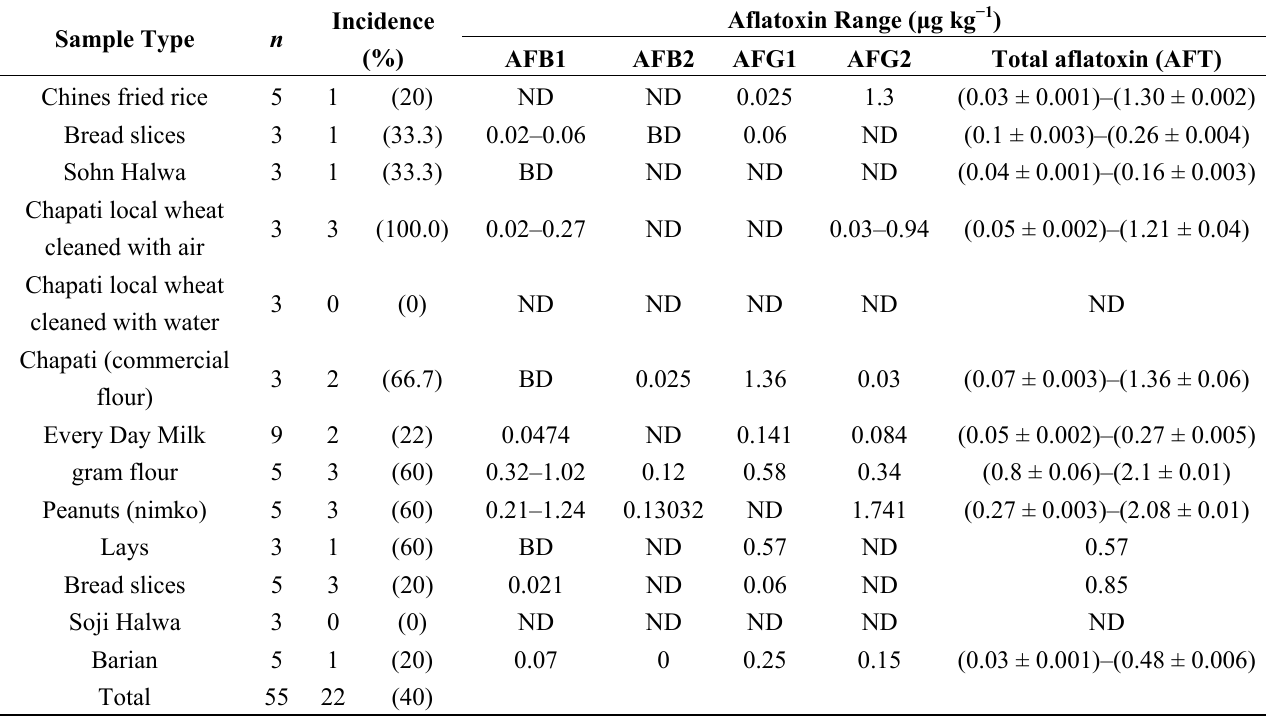
Table 3. Incidence level and range of different types of aflatoxins in processed